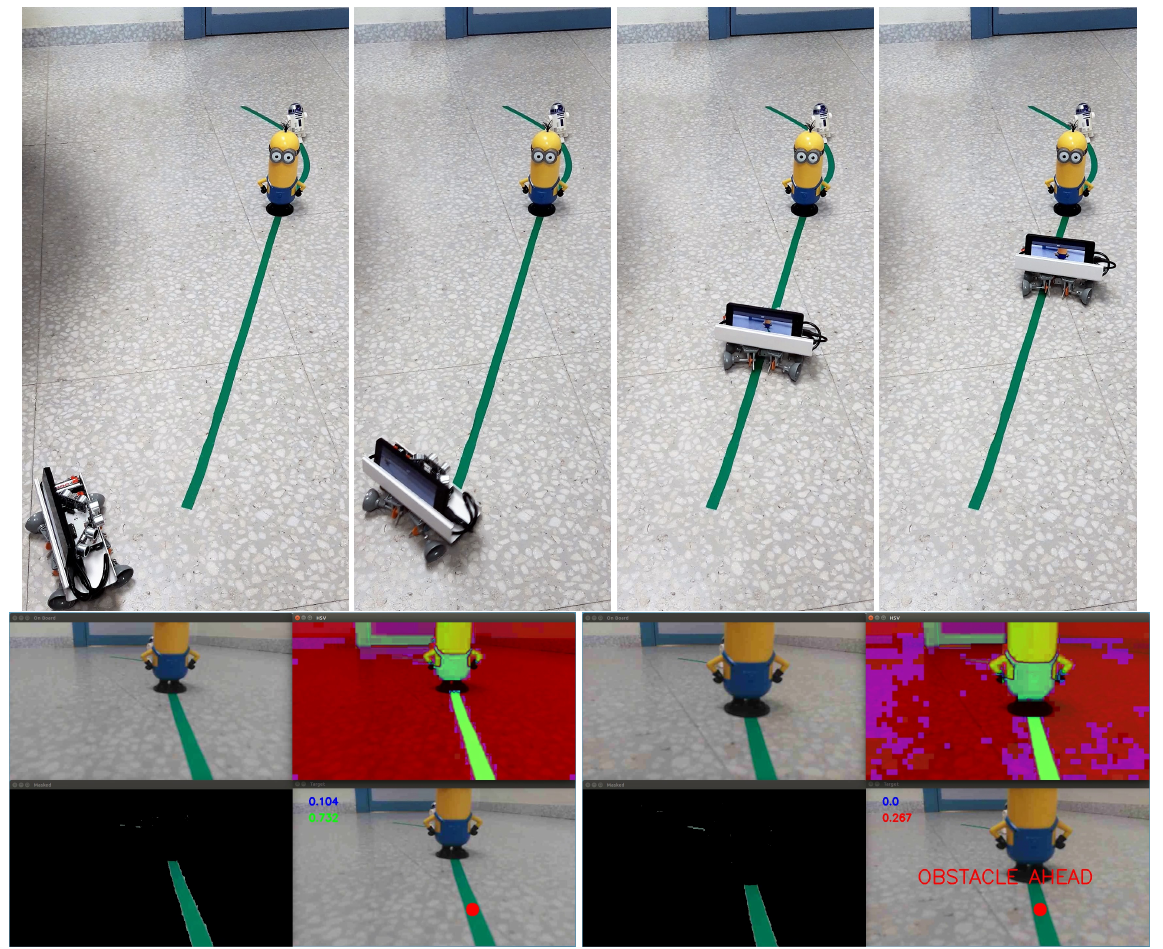
Figure 11. Andruino-R2 performing a visual line-tracking task using Android camera, detects and obstacle, and stops when it is close